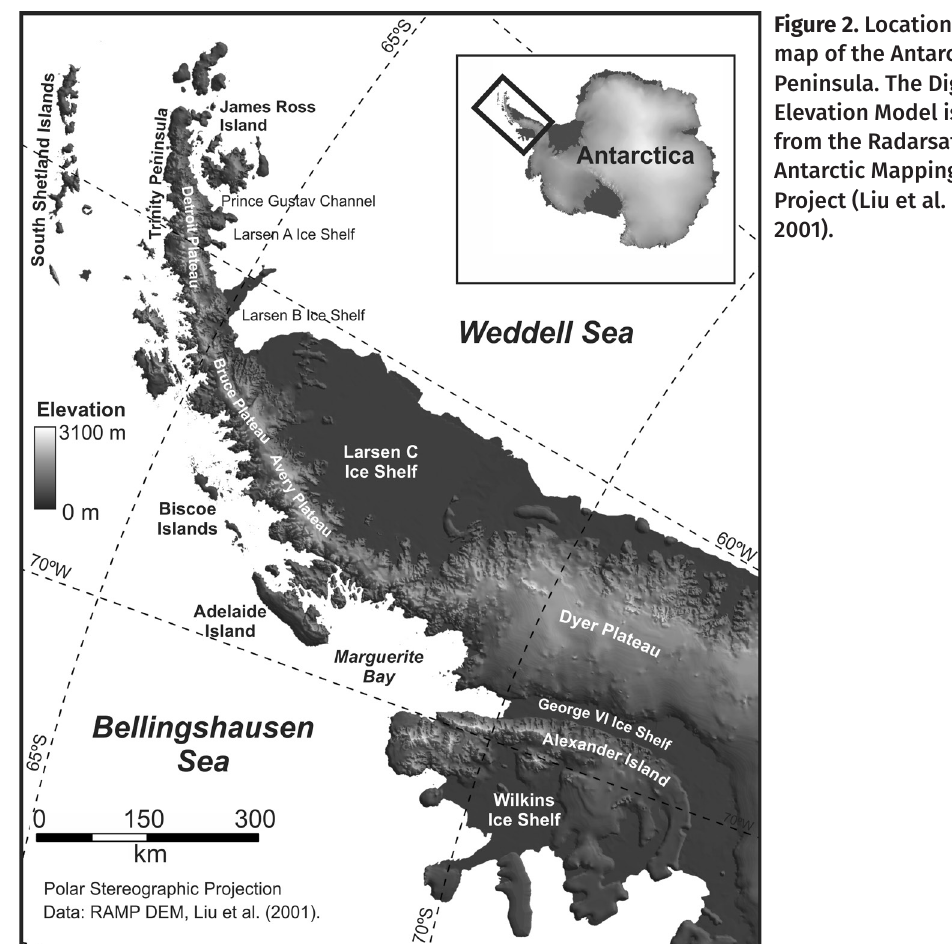
Figure 2. Location map of the Antarctic Peninsula. The Digital Elevation Model is from the Radarsat Antarctic Mapping Project (Liu et al.